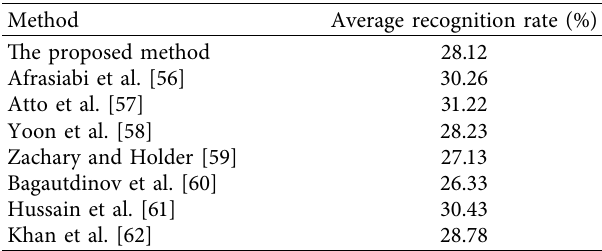
Table 8: Compared with other approaches on MLB-YouTube classes (strong occlusion and high dynamic